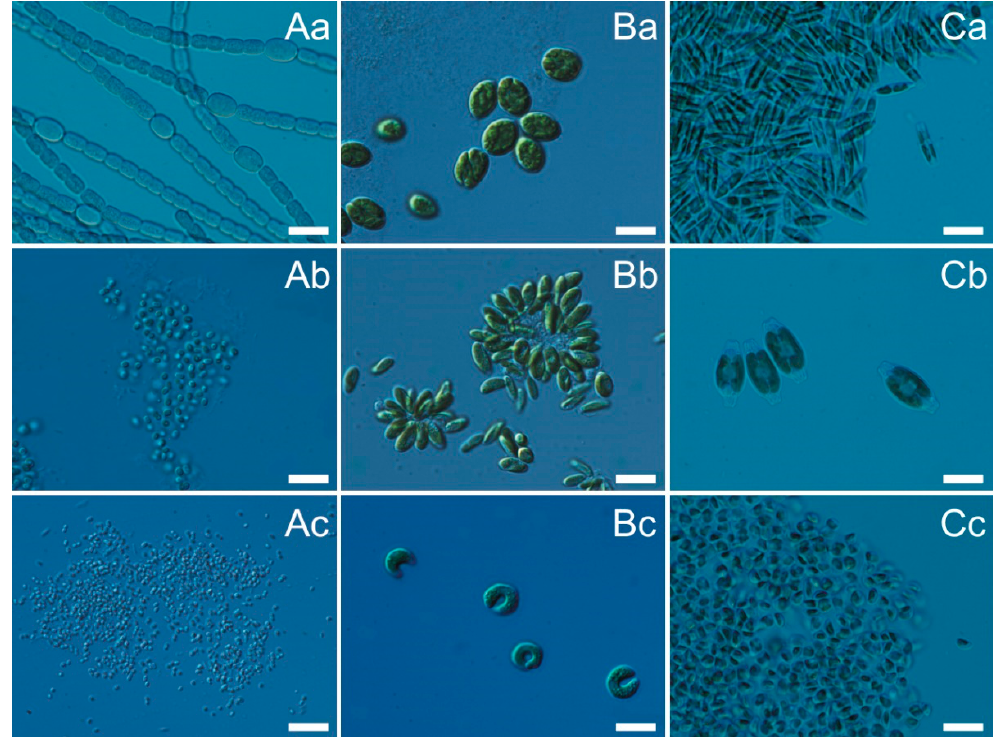
Figure 8. Photographs of airborne cyanobacteria ( A ): Nostoc sp. (CCAA 03; ( a )), Synechococcus sp. (CCAA 14; ( b )), Aphanothece sp. (CCAA 48; ( c )), green algae ( B ): Oocystis sp. (CCAA 20; ( a )), Coccomyxa sp. (CCAA 21; ( b )), Kirchneriella sp. (CCAA 38; ( c )), and diatoms ( C ): Nitzschia sp. (CCAA 17; ( a )), Amphora sp. (CCAA 34; ( b )), Halamphora sp. (CCAA 47; ( c )) used in this study. Scale bar = 10 µ